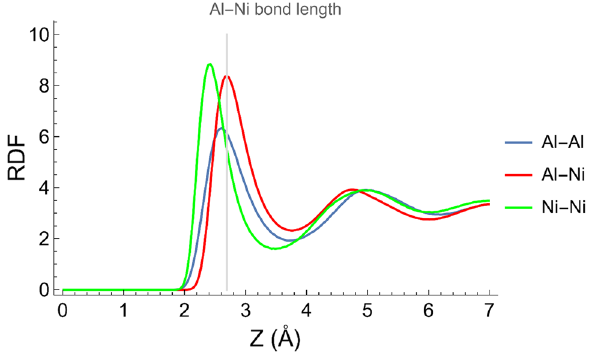
Figure 2. Radial distribution function of elements in Al–0.5Ni and bond length of Al–Ni (For interpretation of the references to color in this figure legend, the reader is referred to the web version of this article).